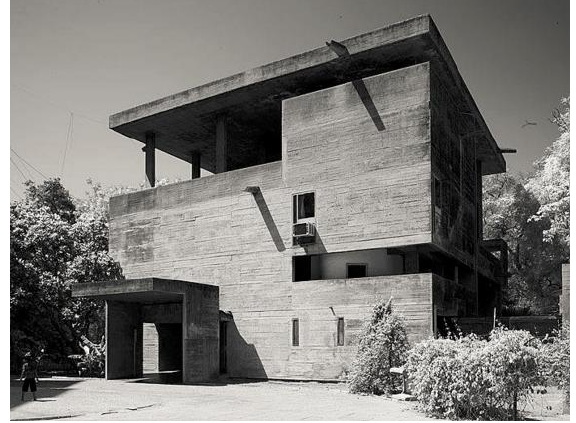
Figure 15. Villa Shodhan, Ahmedabad 1951.